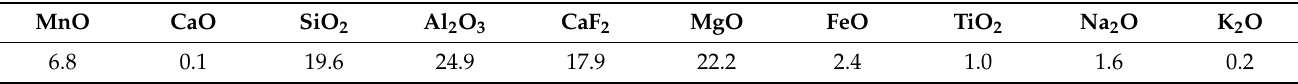
Table 2. Flux bulk chemical composition